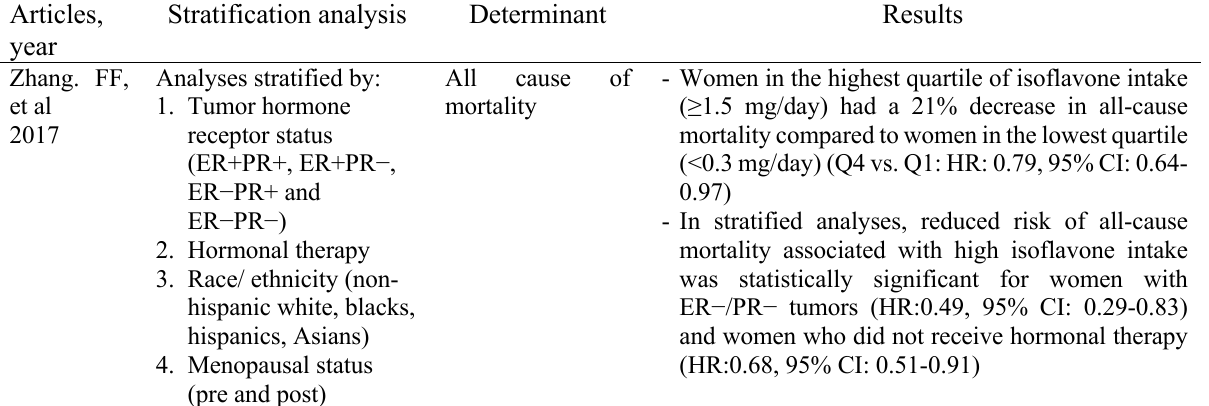
Table 2. Design and results of the selected articles (continued) Articles,